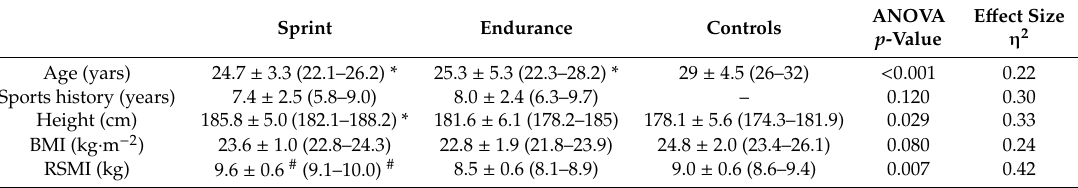
Table 1. Basic characteristics of the athletic groups and